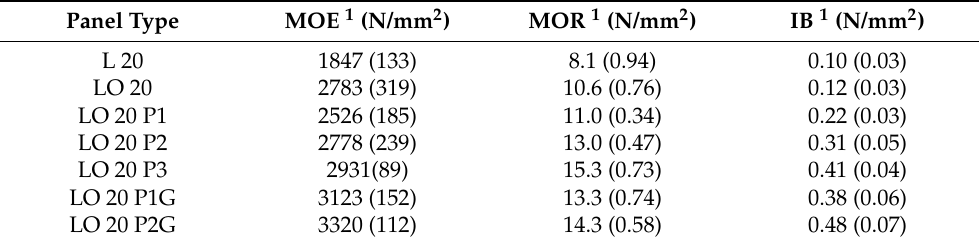
Table 5. Experimental results on the mechanical properties of the tested